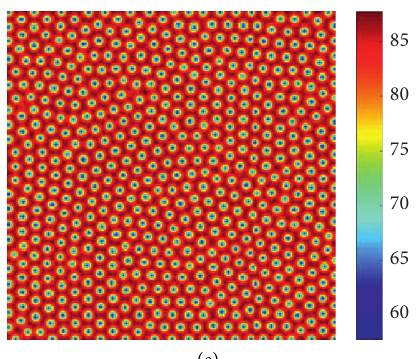
Figure 7: The transitions patterns of the predator induced by the conversion rate of the prey into predator biomass and the other parameters are set in Table 6. Iterations: (a) 0.007041633659; (b) 0.008509501103; (c) 0.009332994621; (d) 0.01032204568; (e)